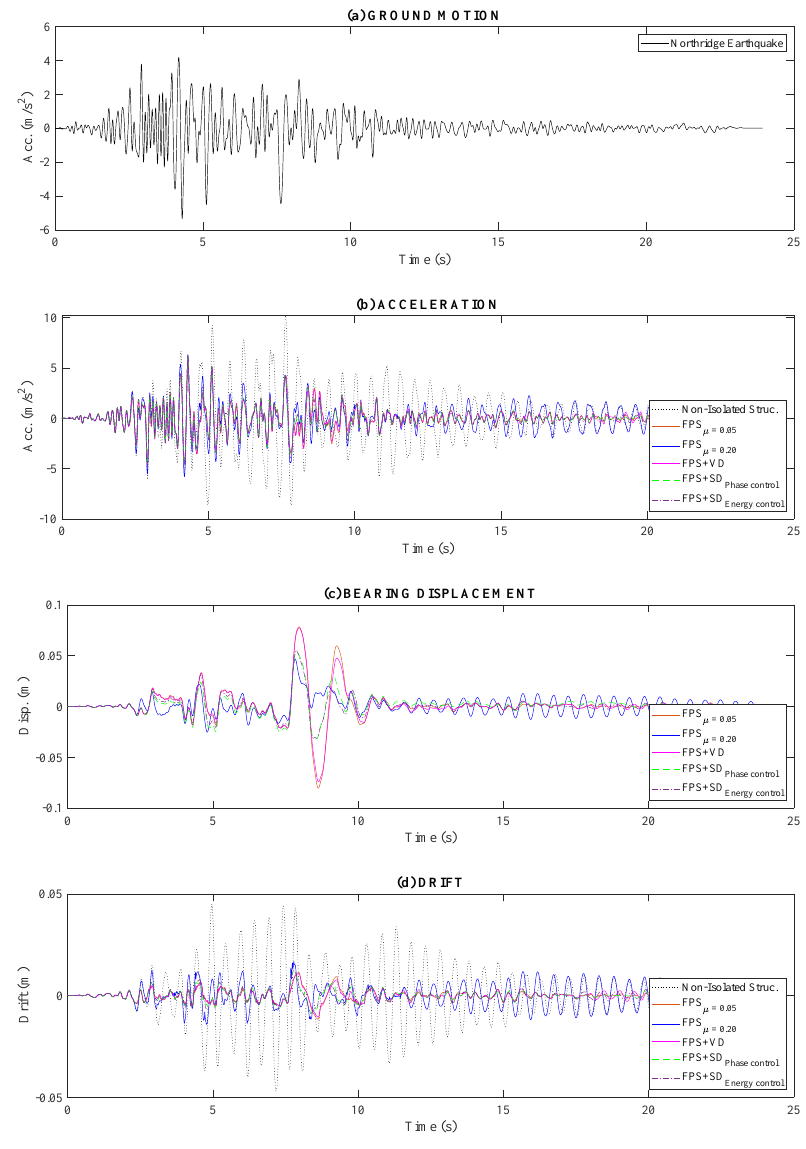
Figure 15. Time history (TH) to Northridge earthquake for the five isolator configurations